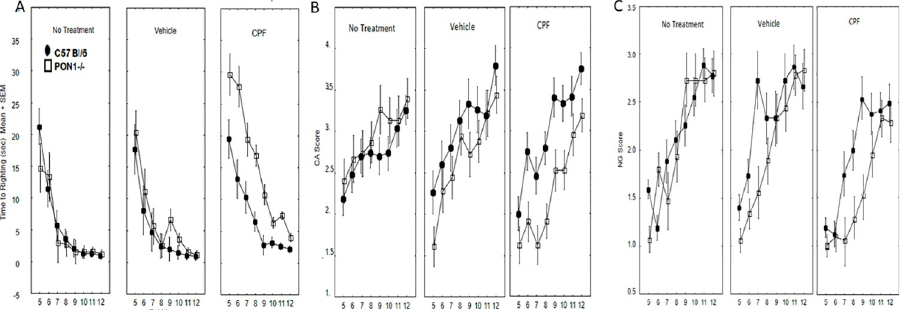
Fig 3. Mean + SEM scores of neonatal reflexes. A: Righting reflex, B: Cliff Avoidance and C: Negative Geotaxis. N for each group as in Fig